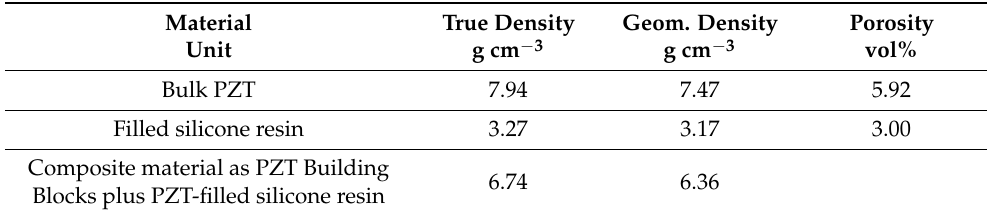
Table 1. Density and the average porosity of the PZT building blocks, the PZT-filled silicone resin, and the produced composite material.